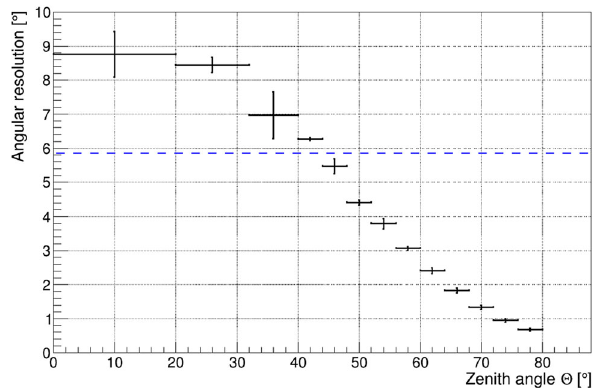
Fig. 5 Zenith angle resolution of the Muon Monitor as the function of the zenith angle. The blue dashed line represents the global resolution